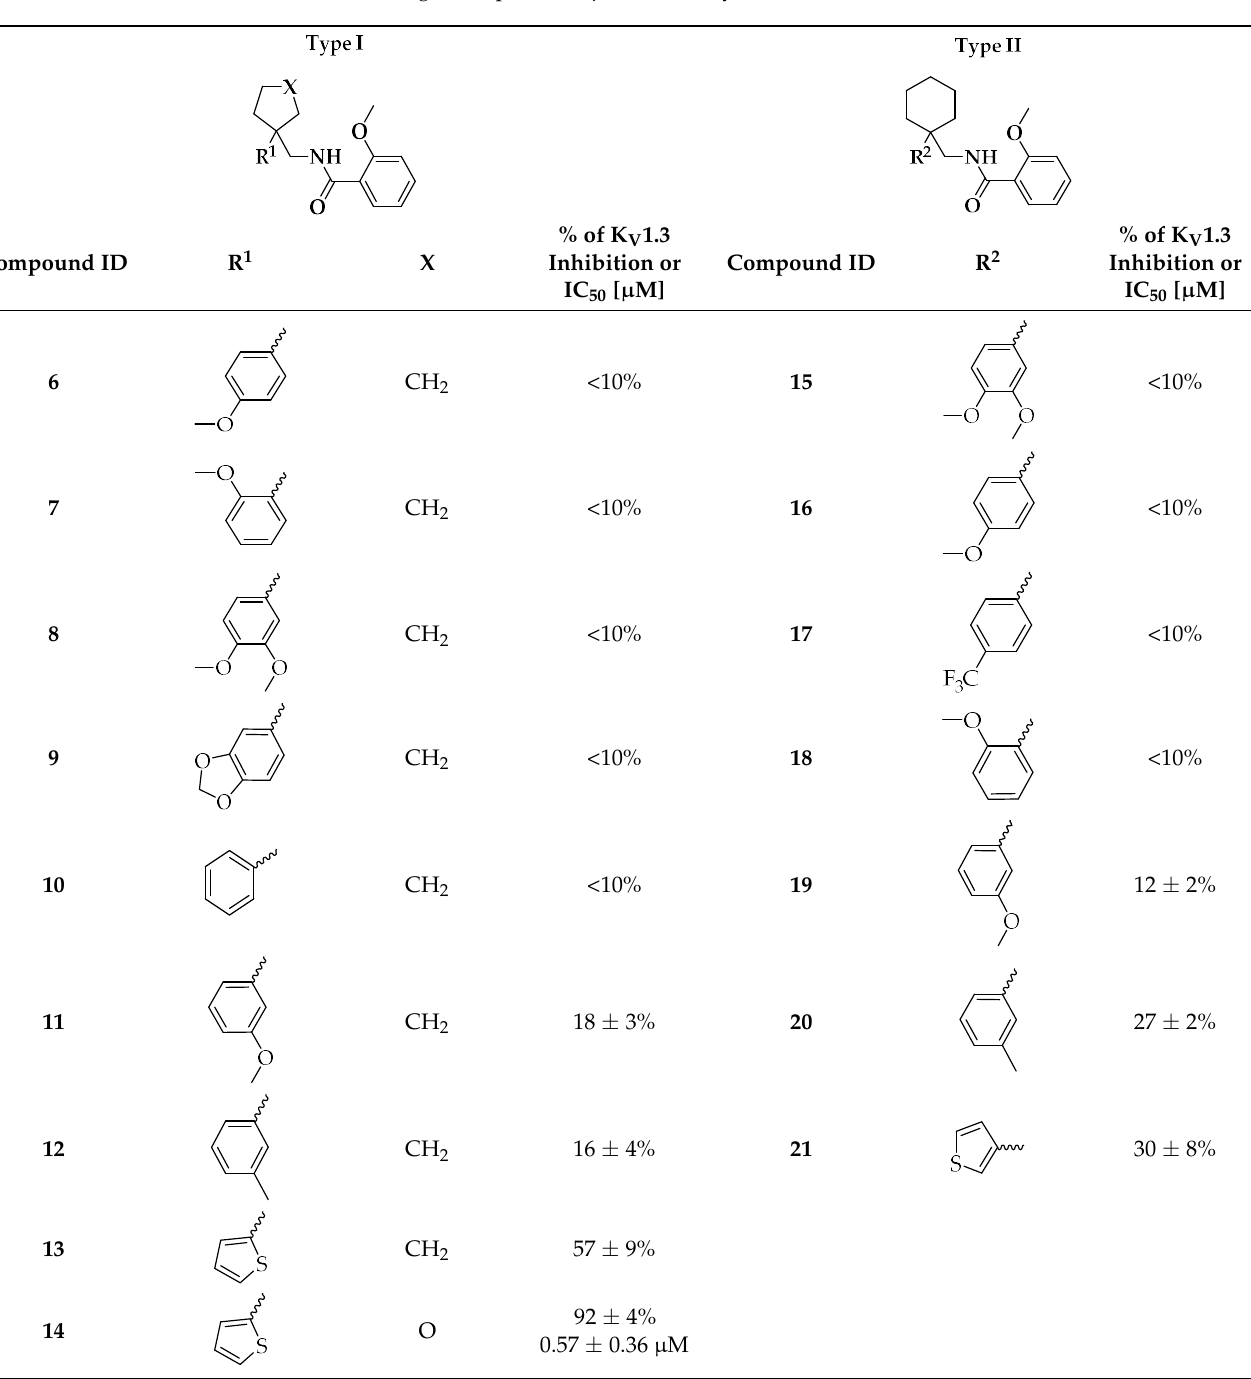
Table 1. K V 1.3 inhibitory activities of new analogs 6 – 21 from Type I and II series, manually voltage- clamped to determine the percentage of inhibition at 10 µM and the IC 50 s values determined with manual voltage-clamp on Xenopus laevis oocytes.